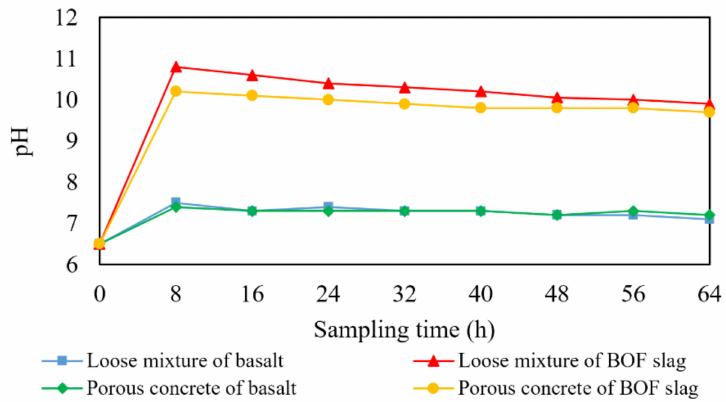
Figure 3. pH vs. time of runoff solution infiltrating through different specimens.